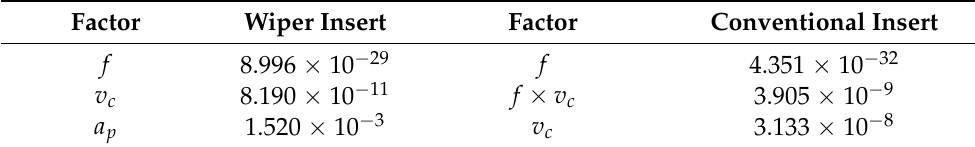
Table 4. The calculated p -values of variables in ANOVA analysis [6].